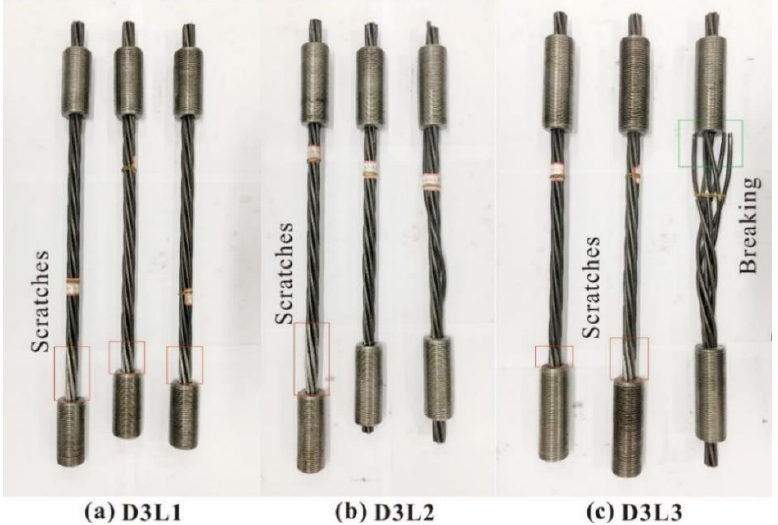
Figure 11. Failure mode of flexible bolt with Ø 42 mm locking casing: ( a ) D3L1, ( b ) D3L2, and ( c ) D3L3.